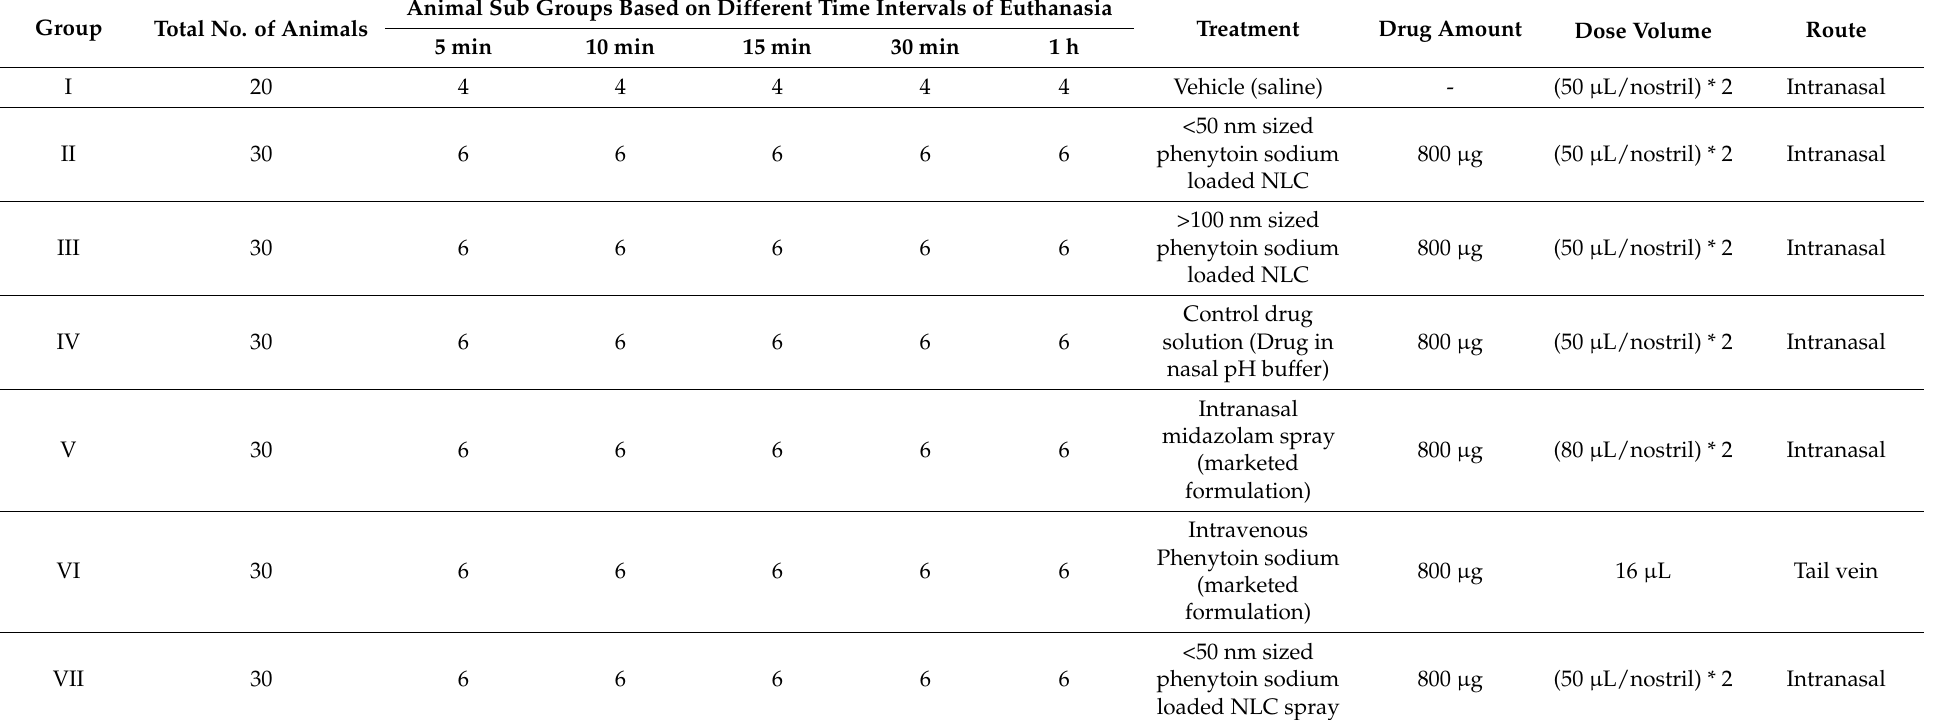
Table 1. Study design for in vivo pharmacokinetic